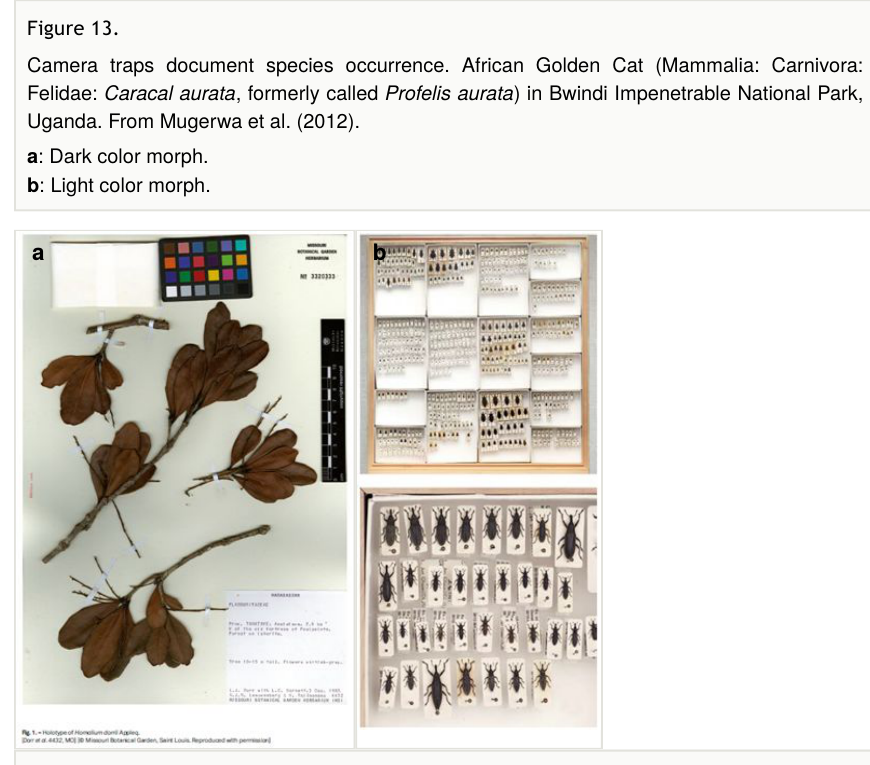
Figure 14. Images of specimens from museum